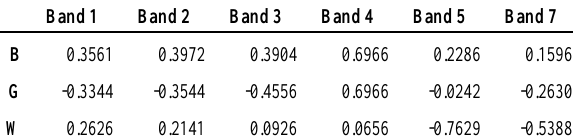
Table 1. Tassled Cap coefficients for Landsat (Huang et al.,